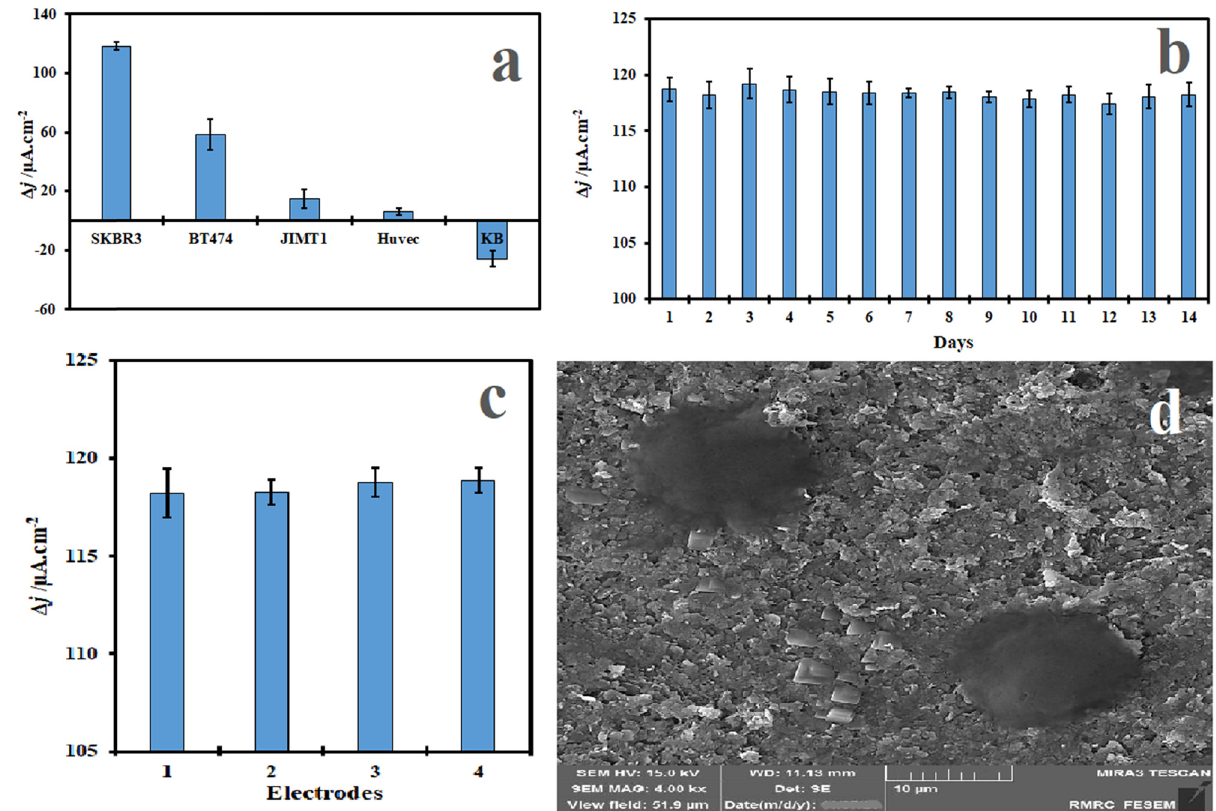
Figure 8: ( a ) The selectivity of g - aptasensor in contact with 5.0 × 10 4 cells/mL from SKBR3, BT - 474, JIMT1, Huvec, and KB cell lines, individually, ( b ) stability of g - aptasensor for detecting of 5.0 × 10 4 cells/mL SKBR3 cells within 14 days, ( c ) reproducibility of g - aptasensor for detecting of 5.0 × 10 4 cells/mL SKBR3 cells with 4 electrodes, separately; each measurement was repeated at least 3 times. ( d ) FE - SEM images of SKBR3 cells on the surface of g -